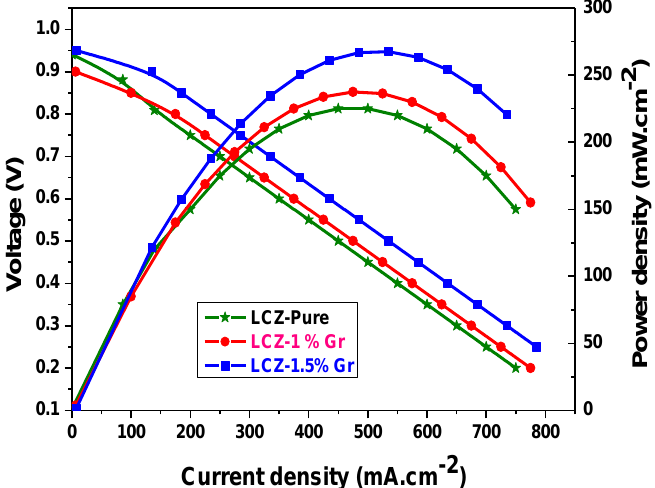
Figure 8. Fuel cell performance of prepared composite materials at 600 °C.